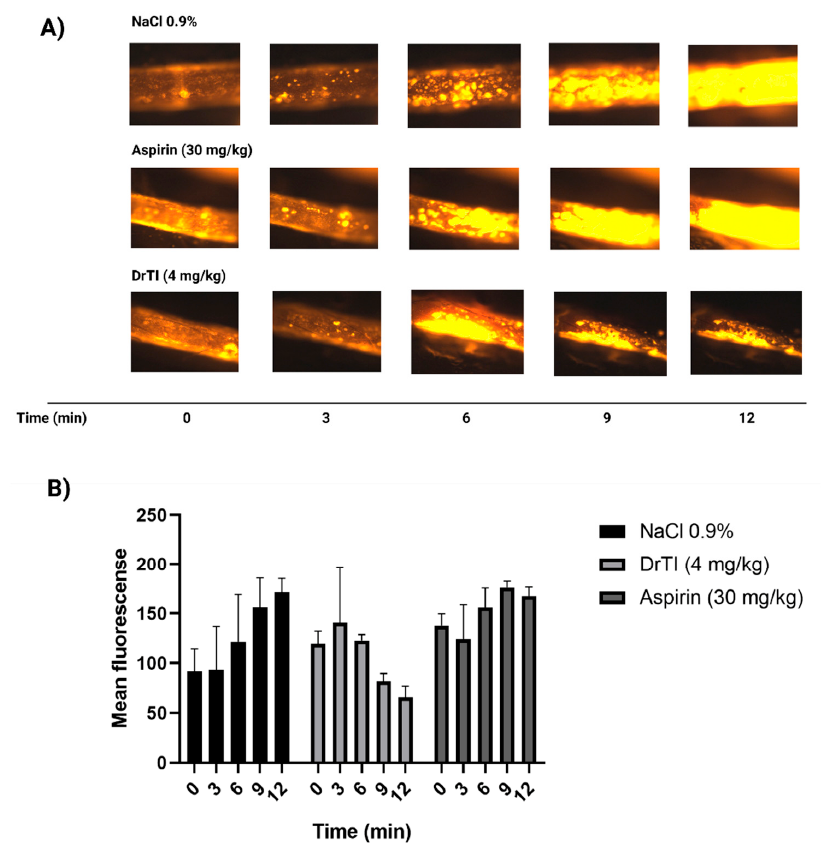
Figure 5. Platelet behavior after treatment with DrTI and Aspirin—( A ) DrTI (4 mg/kg), Aspirin (30 mg/kg), and NaCl (0.9%) were administered by retro-orbital injection and aspirin by gavage 30 min before dissection. Rhodamine 6G was administered by retro-orbital injection to label mitochondria in platelets and leukocytes. Arterial injury was induced by the application of filter paper saturated with 15% FeCl 3 . The injured artery was monitored for 12 min with an image capture every 3 min using an intravital fluorescence microscope. ( B ) Mean fluorescence was quantified using the software ImageJ version 1.46r. N = 3 animals.